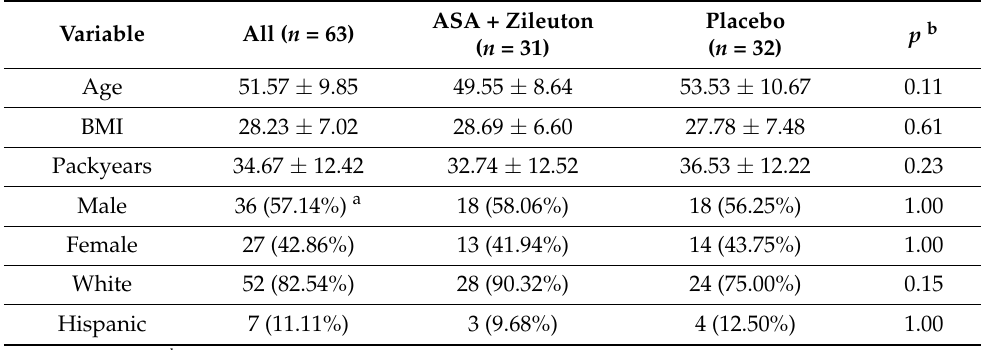
Table 2. mean ± standard deviation.